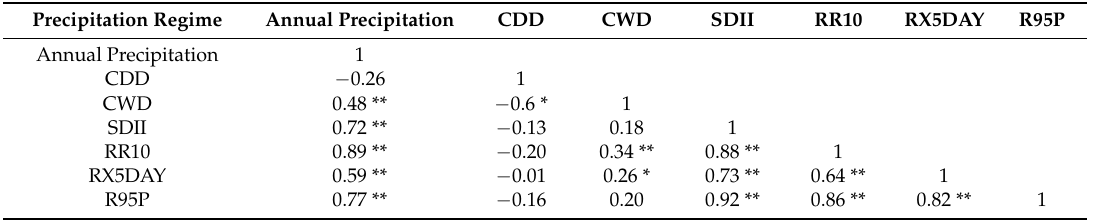
Table 5. Correlation coefficients of extreme precipitation